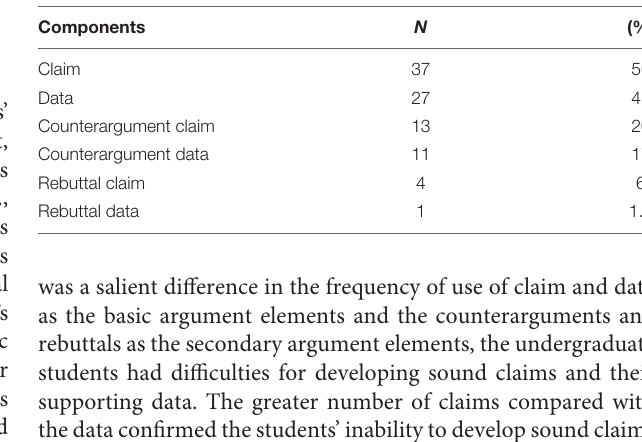
TABLE 4 | Frequency of argument elements in the students’ argumentative